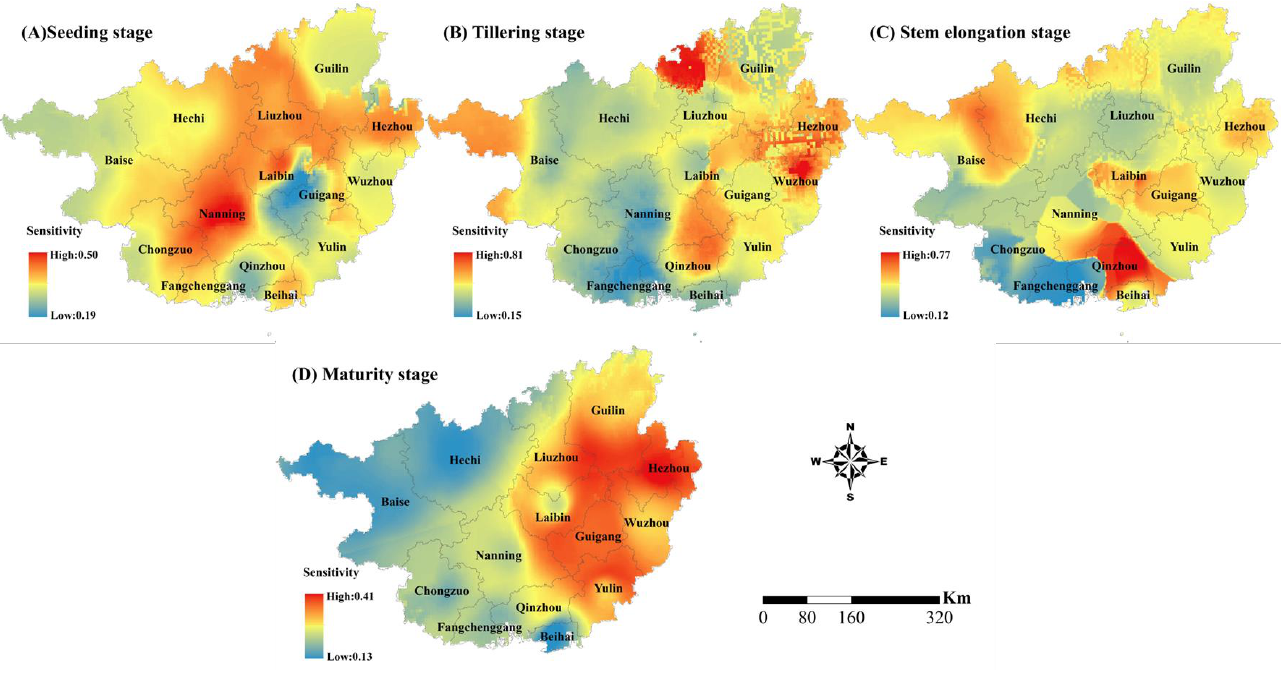
Figure 7. Spatial changes in the drought disaster sensitivity in the four growth stages of sugarcane in Guangxi. ( A – D ) represent the stages of seedling, tillering, stem elongation, and maturity, respec- tively.